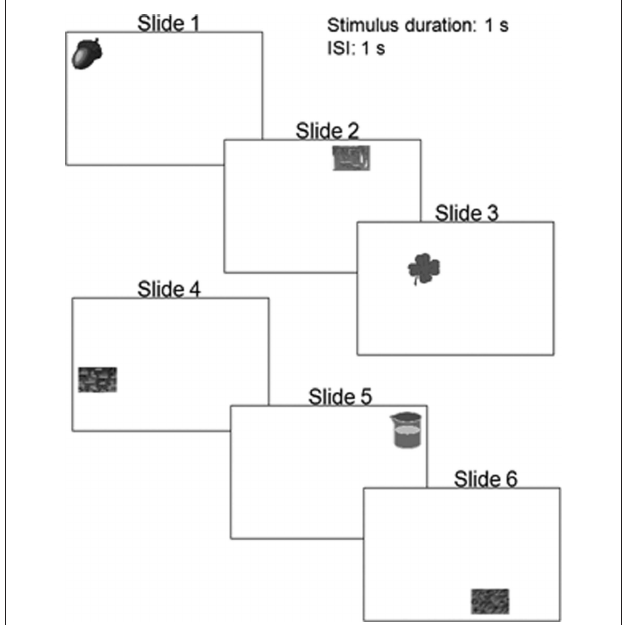
FigurE 2 | Visual spatial memory task: setting and procedures. Examples of stimuli used in the visual spatial memory experiment. Each slide shown here was presented individually during the encoding